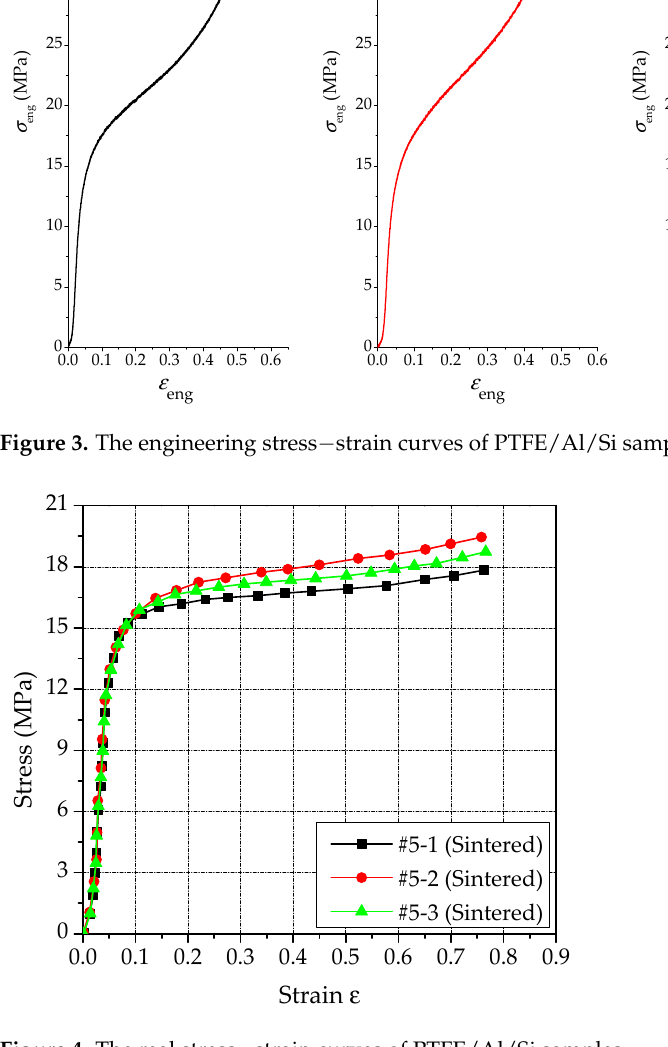
Figure 4. The real stress − strain curves of PTFE/Al/Si samples.